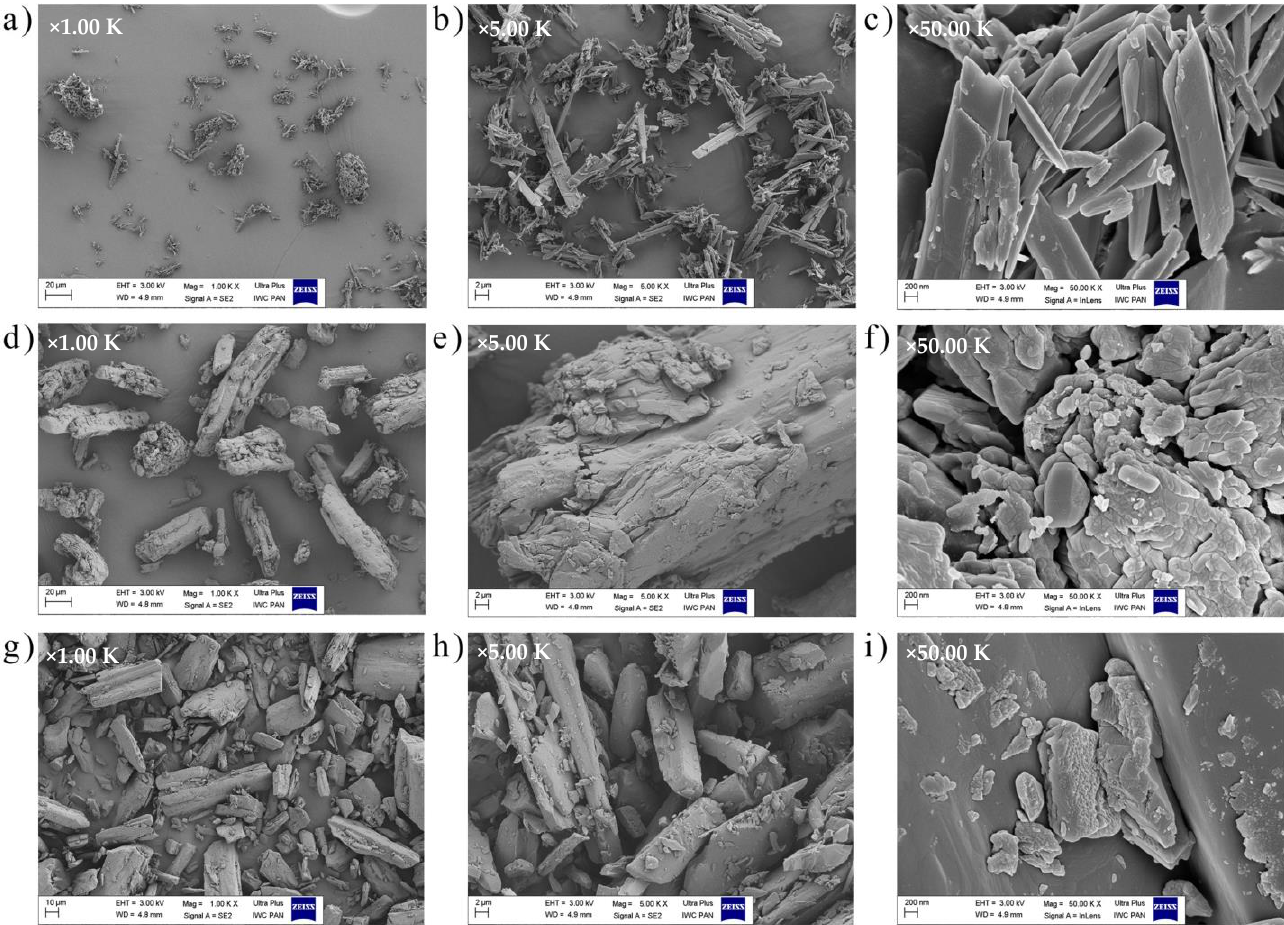
Figure 5. Scanning electron microscopy (SEM) images obtained for ( a – c ) quercetin, ( d – f ) C.I. Solvent Yellow 163, and ( g – i ) C.I. Solvent Red 207 powders at a 1000, 5000, and 50,000× magnification, respectively.